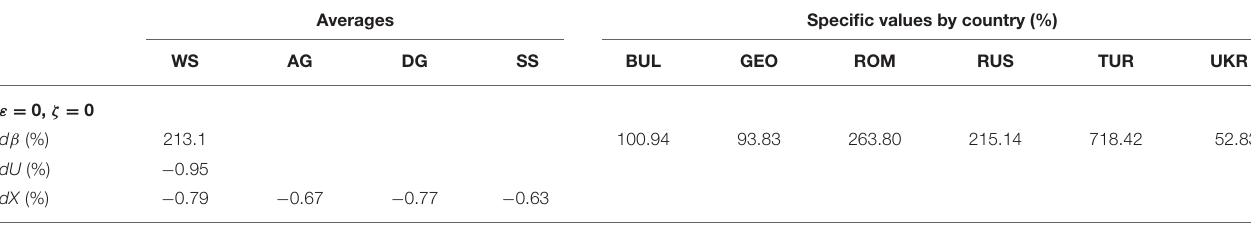
TABLE 11 | Black Sea: cooperative solutions.